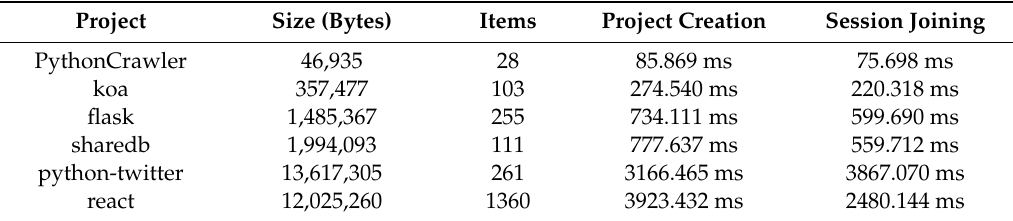
Table 4. Average processing times of project creation (involving source code copy upload) and session joining (involving source code copy download).